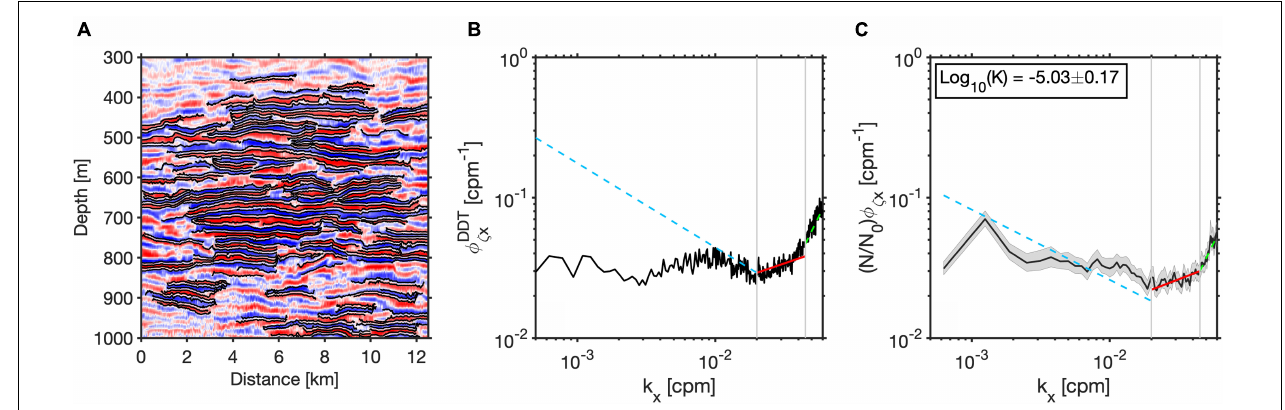
FIGURE 3 | Example of spectral analysis from line 1A (a rolling window used in section “Zonal Variability of Diffusivities”). (A) Seismic data overlapped with tracked reflections. Black lines = tracked reflections. (B) Direct data transform (DDT) of seismic data in panel (A) . (C) Average slope spectrum calculated from all the tracked reflections in panel (A) . Shaded gray area = 95% bootstrap confidence intervals. Dashed blue lines (k - 1 / 2 ), solid red lines (k 1 / 3 ) and dashed green lines (k 2 ) = the internal wave subrange, turbulence subrange and white noise, respectively (Garrett and Munk, 1975; Klymak and Moum, 2007; Holbrook et al., 2013). Two vertical gray lines bound the turbulent subrange used to calculate diffusivity. The calculated diffusivity and its uncertainty are shown in the upper left